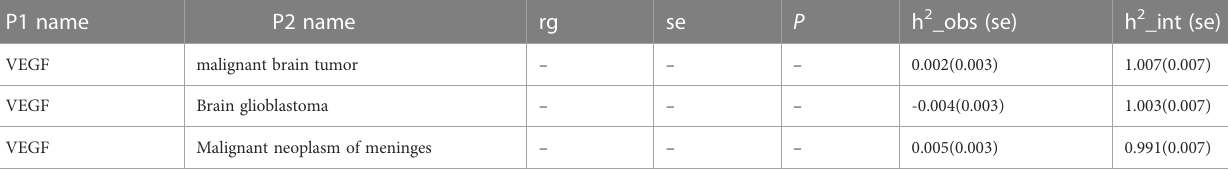
TABLE 3 Genetic correlation between VEGF and different types of malignant brain